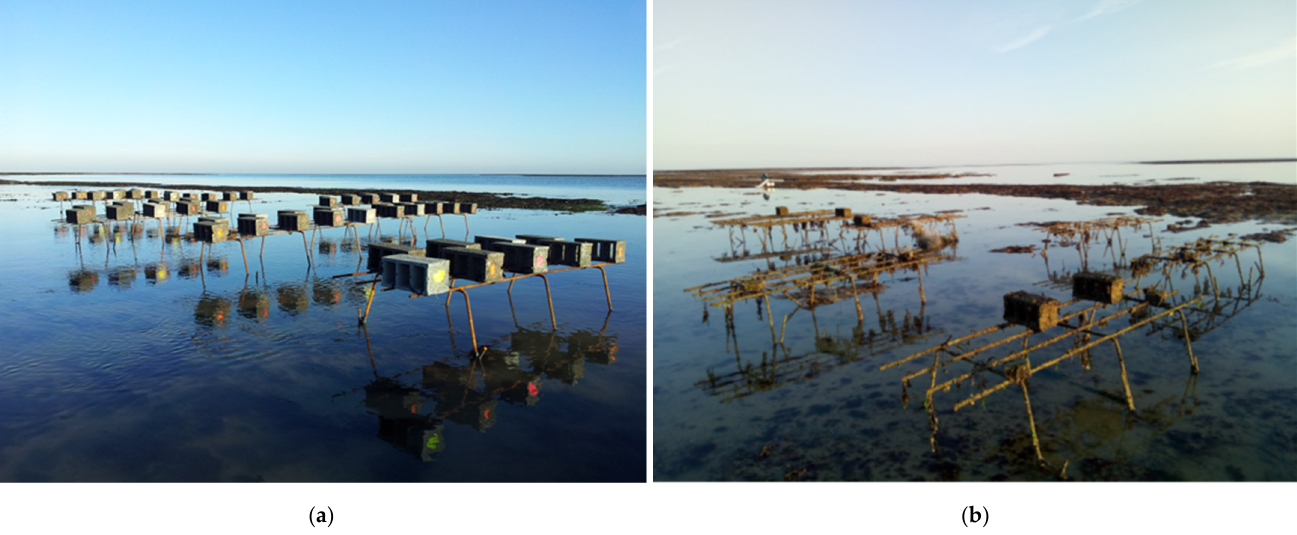
Figure 2. In situ experimental structure. At the beginning of the experiment in March 2014 ( a ) and at the end of the Experiment in April 2018 ( b ).